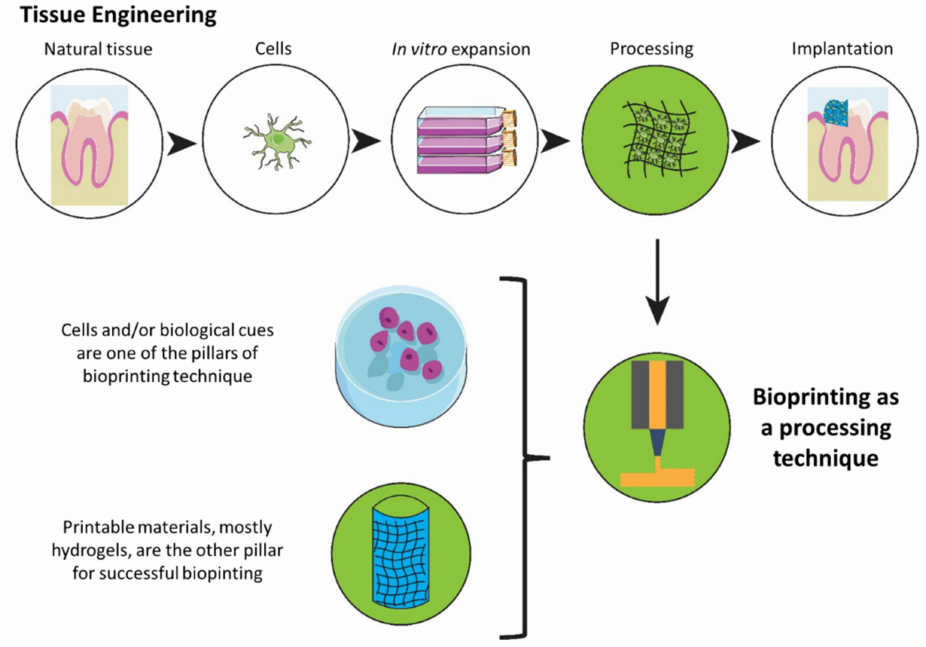
Figure 1. An overview of a tissue engineering process highlighting bioprinting as a promising fabrication technique.